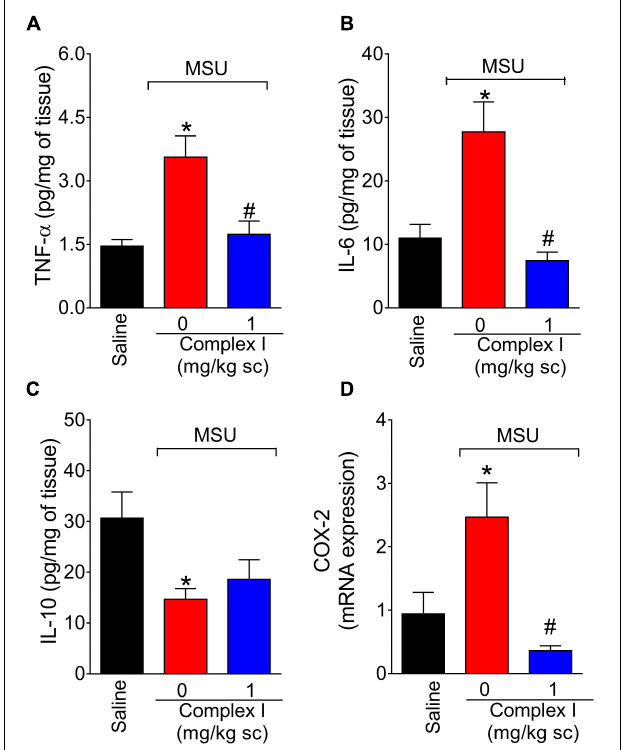
FIGURE 6 | Complex I reduces MSU-induced cytokine production and cox-2 mRNA expression in the knee joint. Mice were treated with complex I (1 mg/kg/saline, s.c.) or vehicle 30 min prior to intra-articular stimulation with MSU (100 µ g/10 µ l) and after 15 h knee joints samples were collected to measurement of pro-inflammatory TNF- α (A) and IL-6 (B) , anti-inflammatory IL-10 (C) cytokines and cox-2 mRNA expression (D) . Results are expressed as mean ± SEM ( n = 6 per group per experiment, representative of two experiments). ∗ p < 0.05 compared to saline group and # p < 0.05 compared to MSU + vehicle. One-way ANOVA followed by Tukey’s